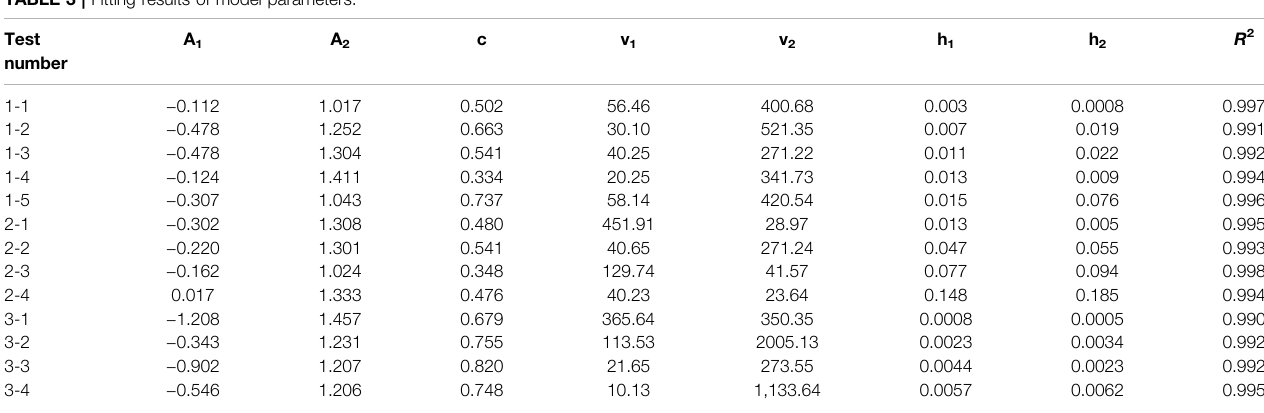
TABLE 3 | Fitting results of model